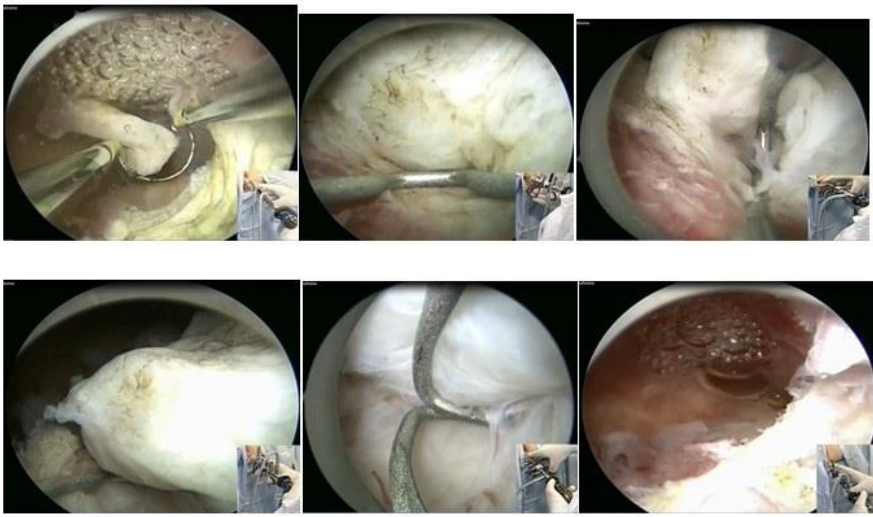
Figure 13. Mazzon technique with “ cold loop ” .